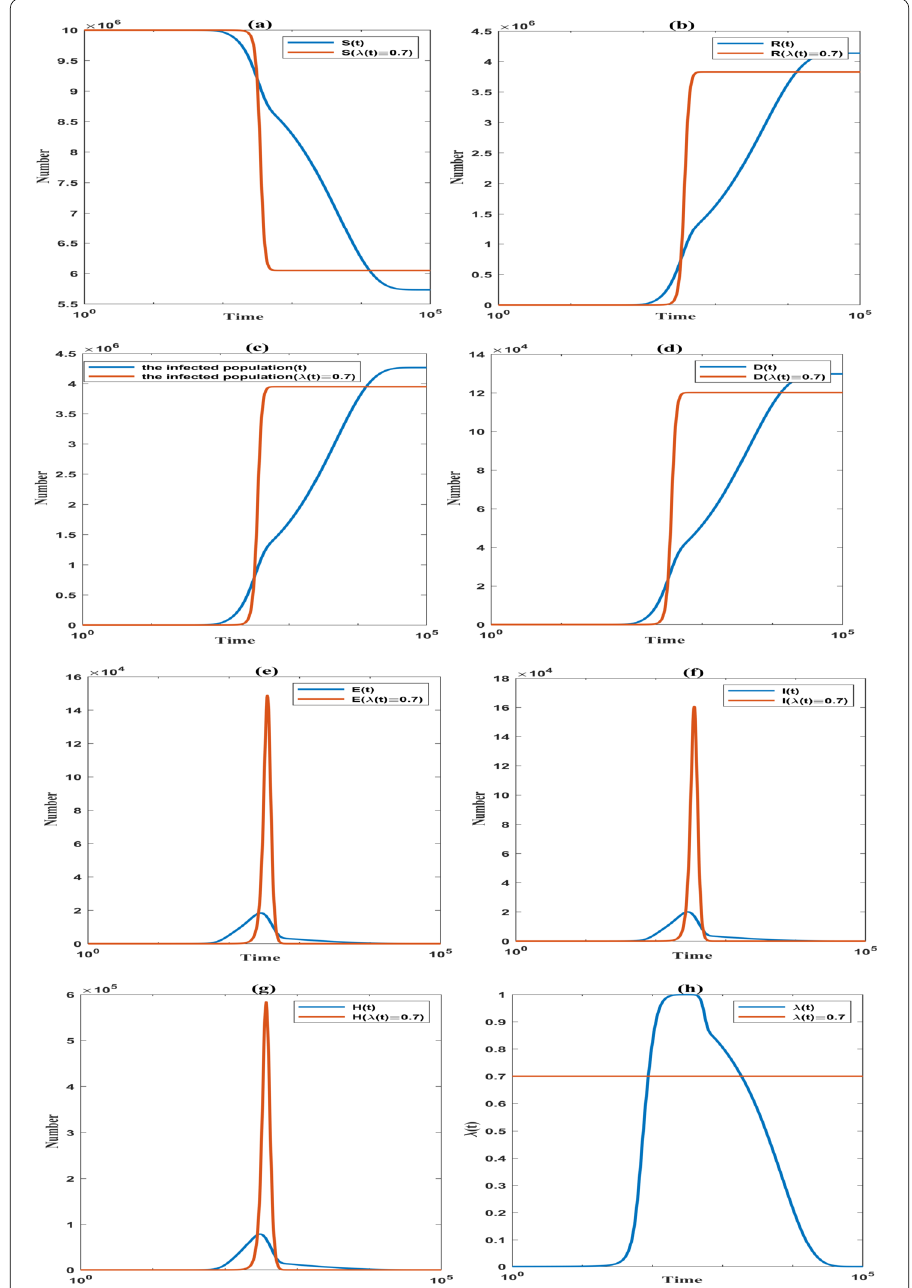
Figure 6 The evolution of the susceptible population ( S ), the recovered population ( R ), the infected population, the death population ( D ), the exported population ( E ), the symptomatic infected population ( I ), the hospitalized population ( H ) for λ ( t ) ≡ 0.7 and λ ( t ) changes with time. The proportion of wearing masks in the susceptible and exported populations λ ( t ) over time. Lateral axis: logarithm of time t